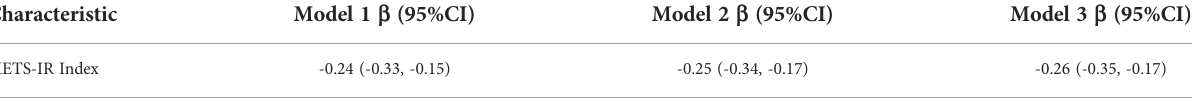
TABLE 4 Analysis between METS-IR index with age at the fi rst gallbladder stone operation. Characteristic